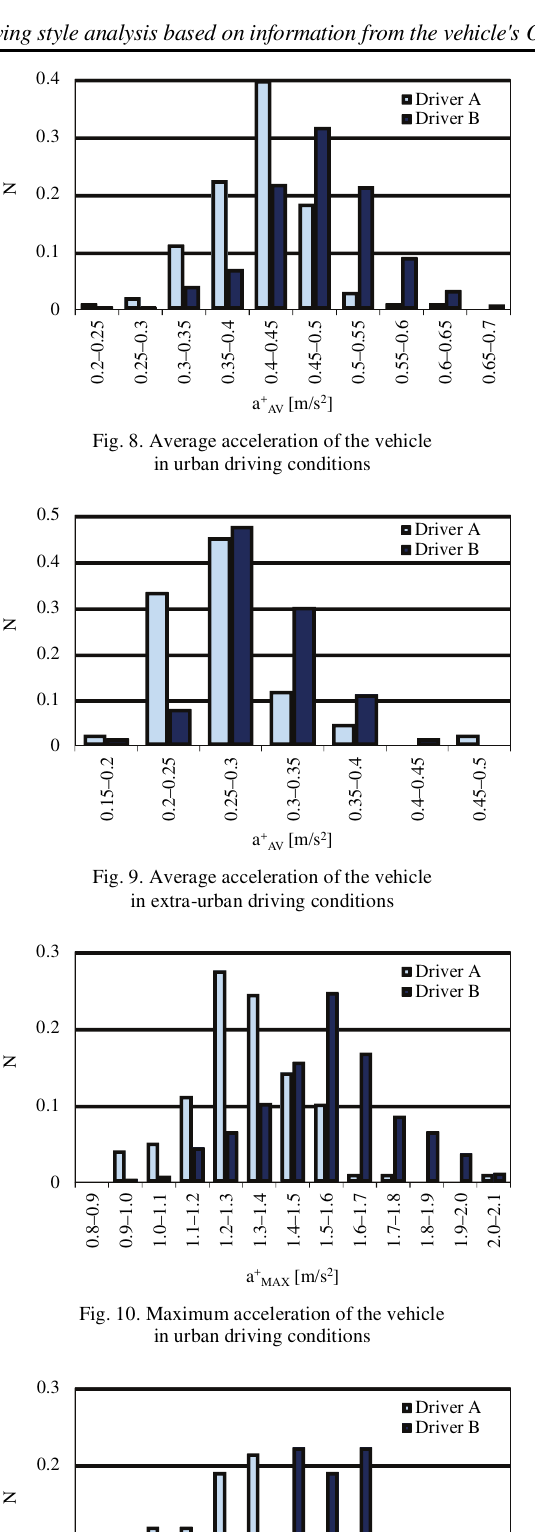
Fig. 14. Maximum deceleration of the vehicle in urban driving conditions